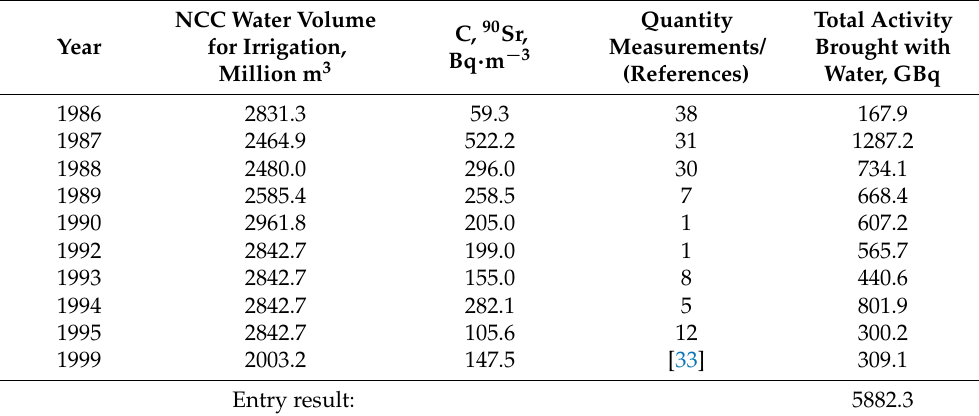
Table 1. Dynamics of the average annual concentrations (C) of 90 Sr in the water of the NCC and the entry of 90 Sr into the territory of Crimea in 1986–1999.